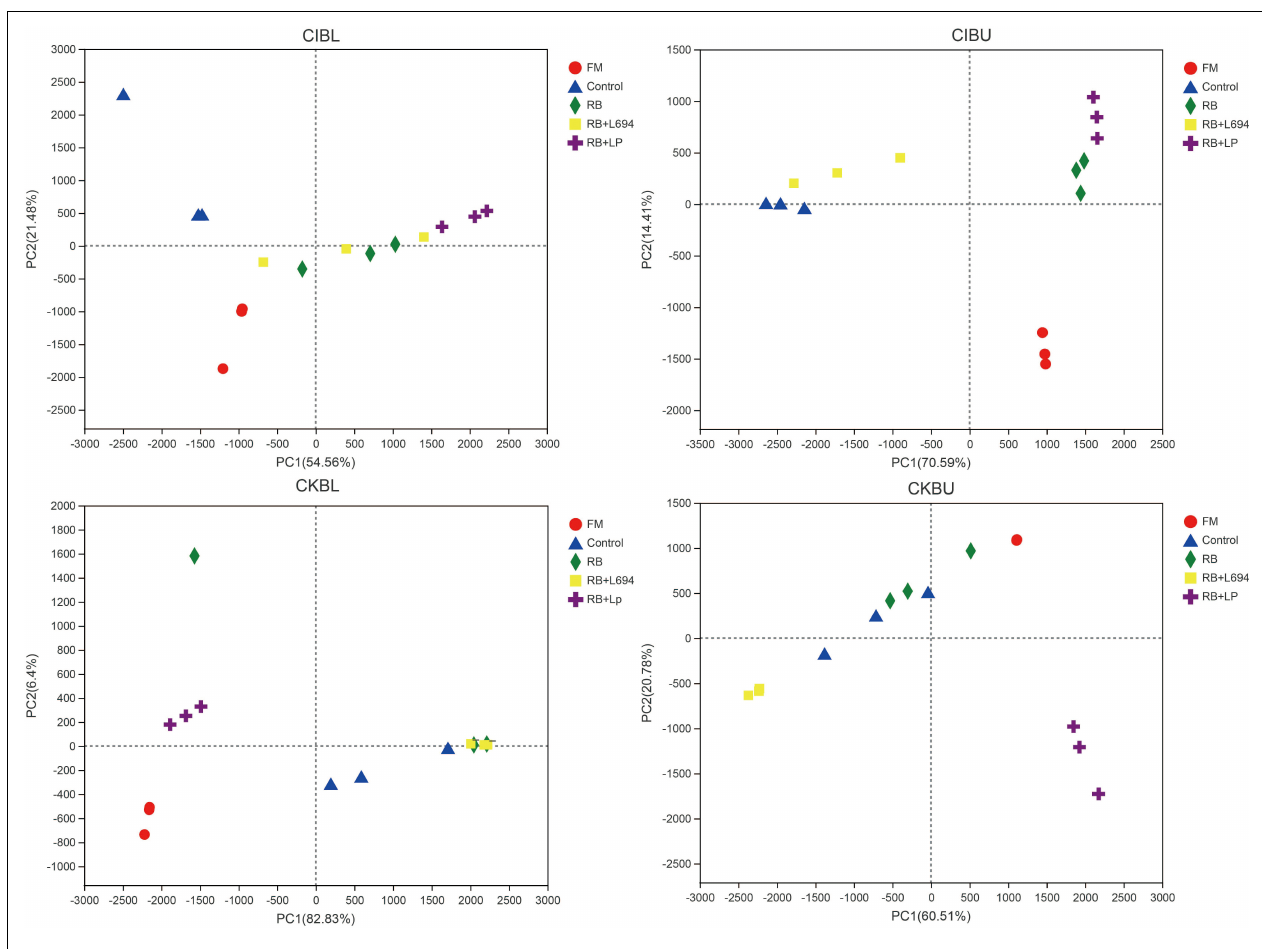
FIGURE 3 | PCA analysis of OTU level for Caragana intermedia (CI) and Caragana korshinskii (CK) silages at the budding (BU) and blooming stages (BL) after 60 days of ensiling. RB, 5% rice bran; LP, commercial inoculant strain Lactobacillus plantarum ; L694, a selected strain Lactobacillus ( n =